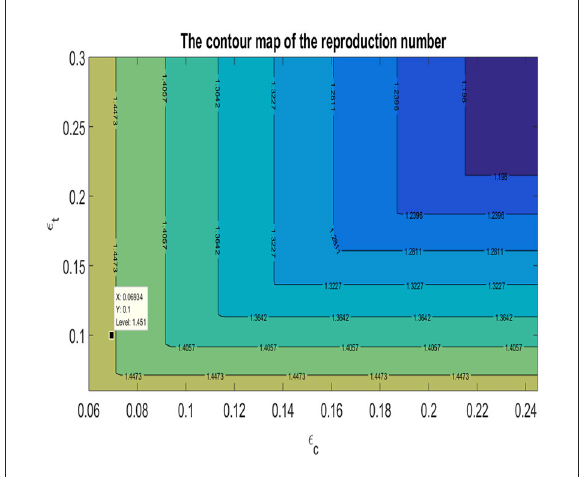
FIGURE4 The trajectories of the infectious